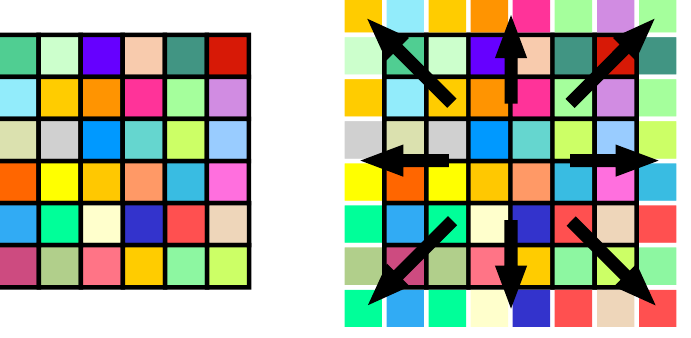
Figure 7. The original image and the extended image. The processed images are shown on the right. Black arrows represent the symmetric mapping.